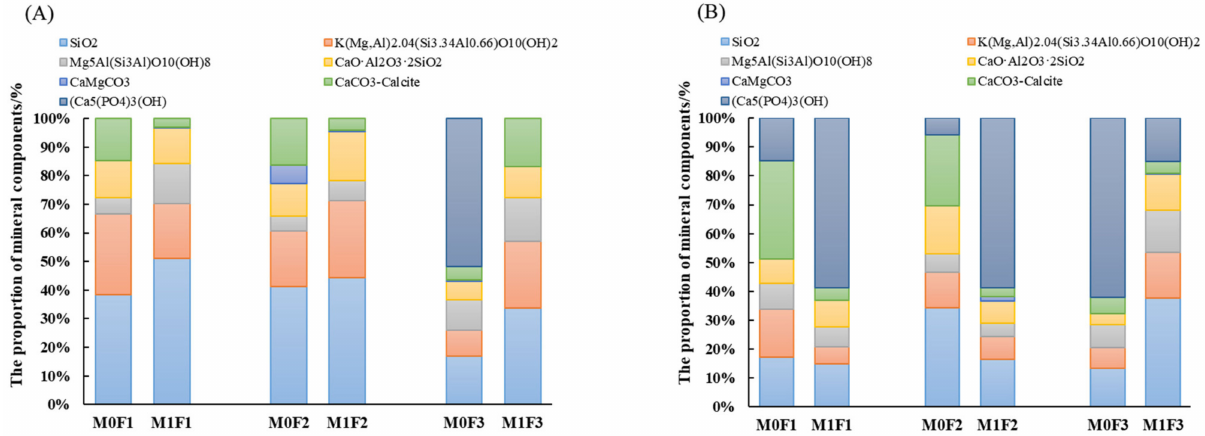
Figure 4. Proportion of mineral composition in the first season ( A ) and the second season ( B